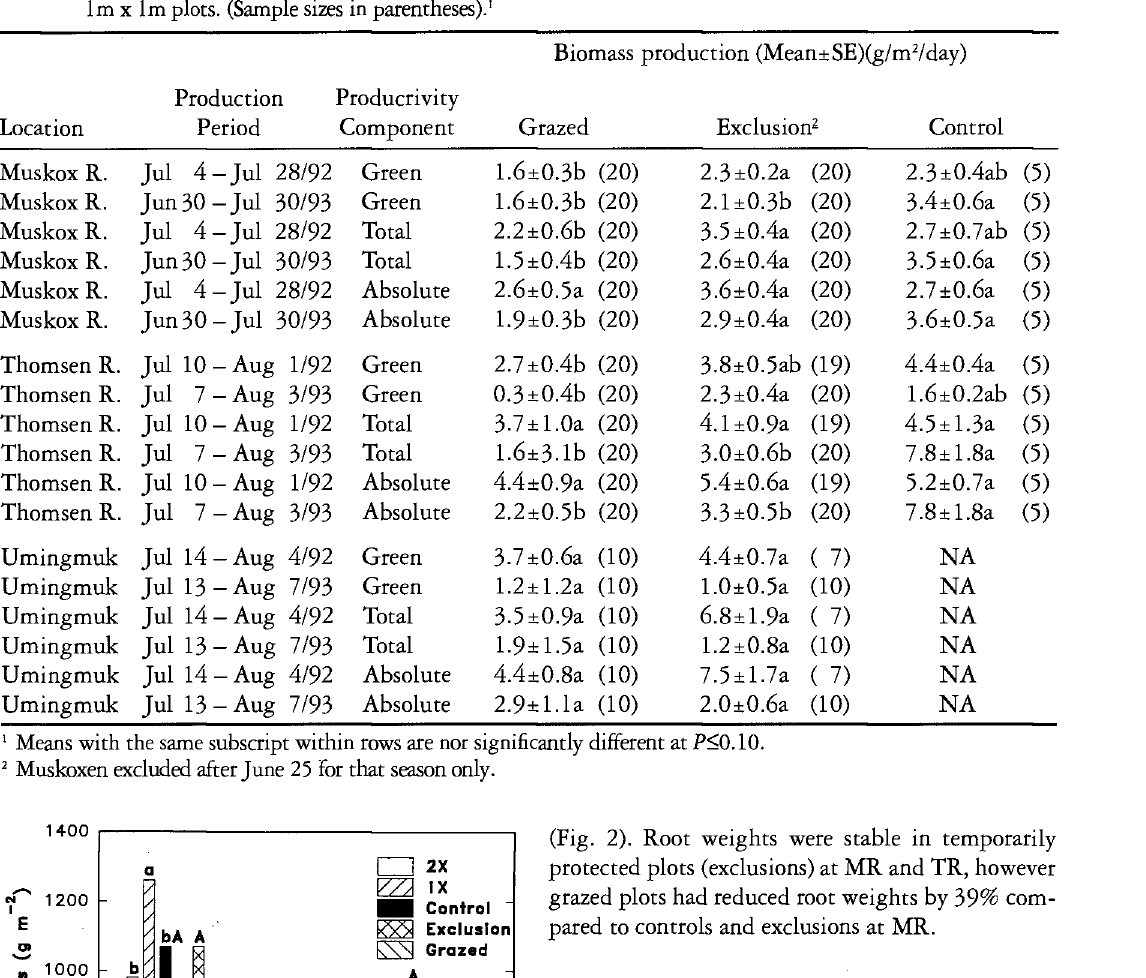
Table 7. Green, total and absolute productivity (g m 2 d 1 ) estimates (Mean±SE) among treatments in 1992 and 1993 lm x lm plots. (Sample sizes in parentheses). 1